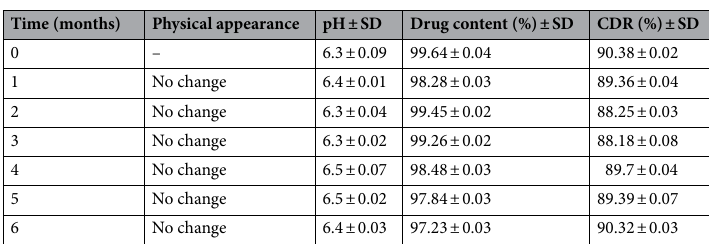
Table 7. Results of stability study of C8